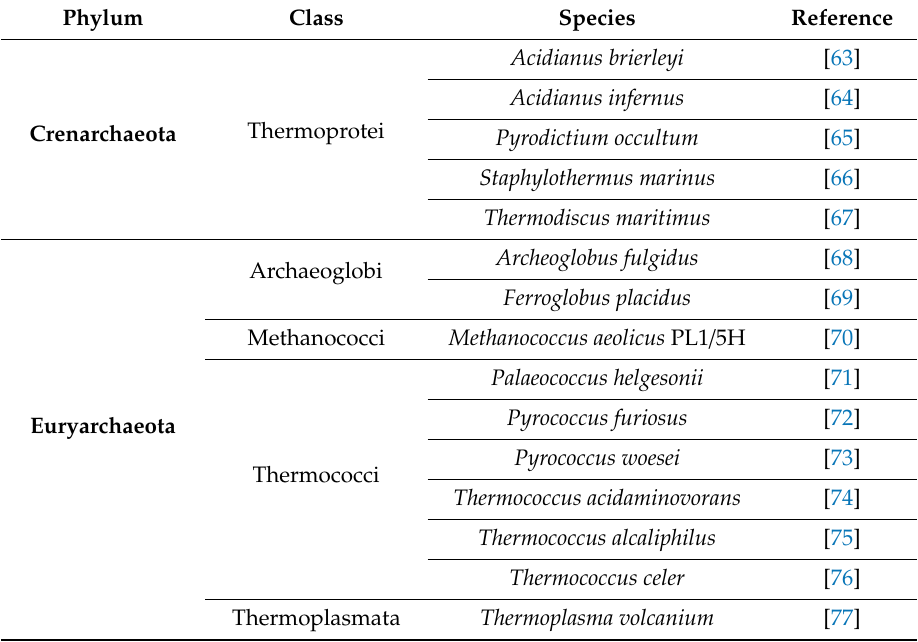
Table 4. Thermophilic and hyperthermophilic archaea isolated from thermal springs of Vulcano Island.